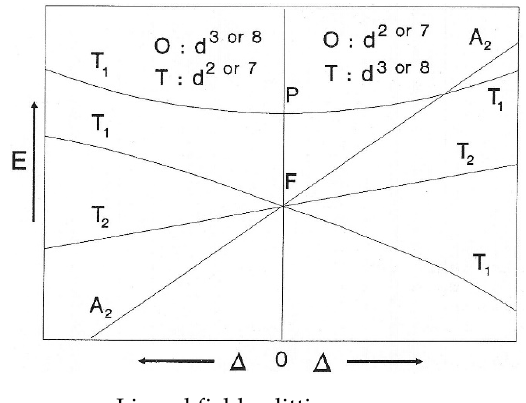
Figure 5. Orgel diagram of T d and O h complexes with two, three, seven (high spin) or eight d electrons [72].